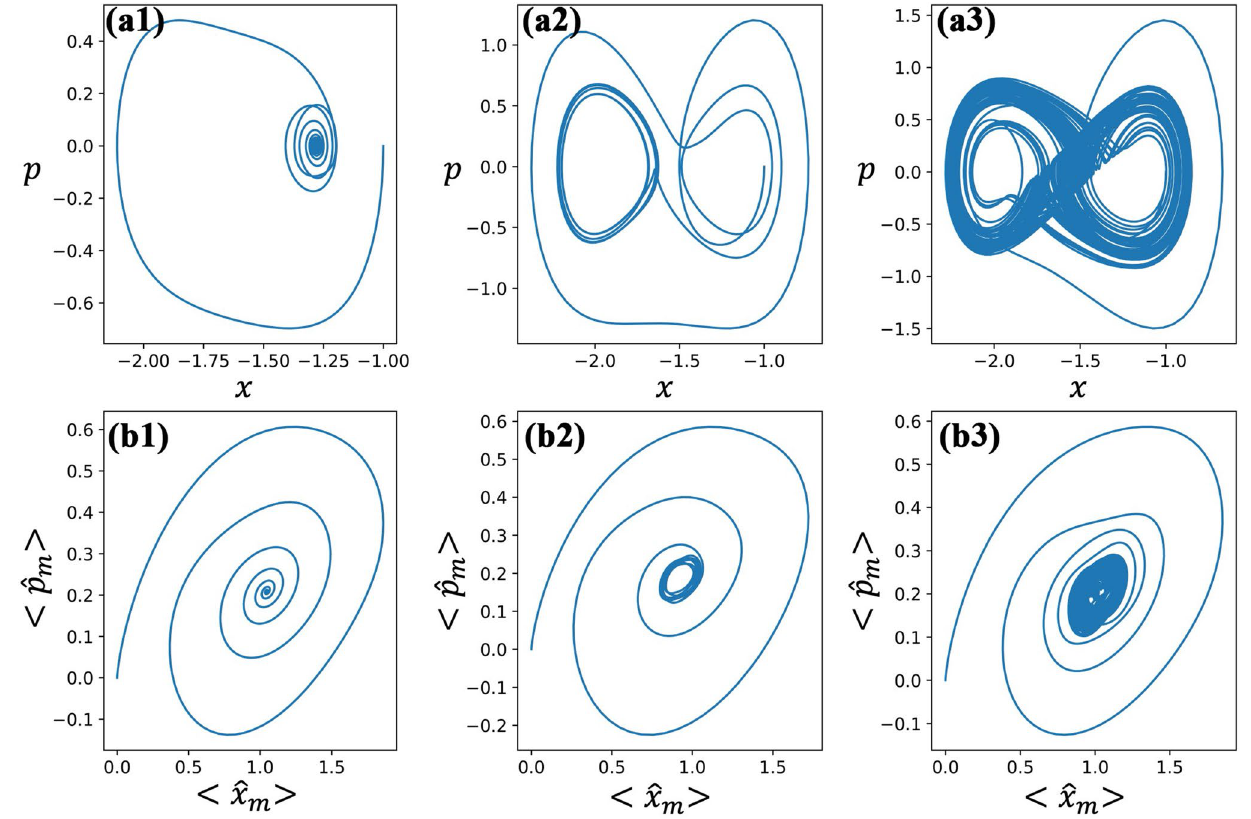
Figure 3. The motion of the atom (first row) and the membrane (second row) in the phase-space diagram. The parameters are given by γ c /γ a = 0.5, γ m /γ a = 2, η/γ a = 5, V 0 /γ a = 20, V 1 /γ a = 40, ω r /γ a = 1, � c /γ a = − 1, and � a /γ a = − 2. For panels ( a1 , b1 ): g ac /γ a = 0.5, g mc /γ a = 2; ( a2 , b2 ): g ac /γ a = 2, g mc /γ a = 2.5; and ( a3 , b3 ): g ac /γ a = 2, g mc /γ a =